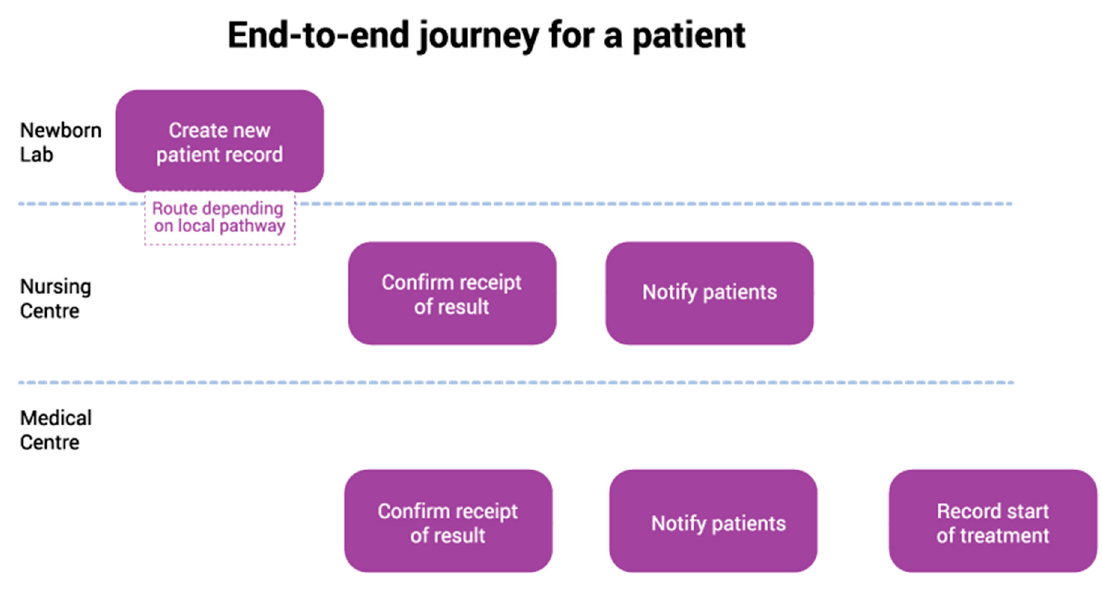
Figure 1. End to end user journey.